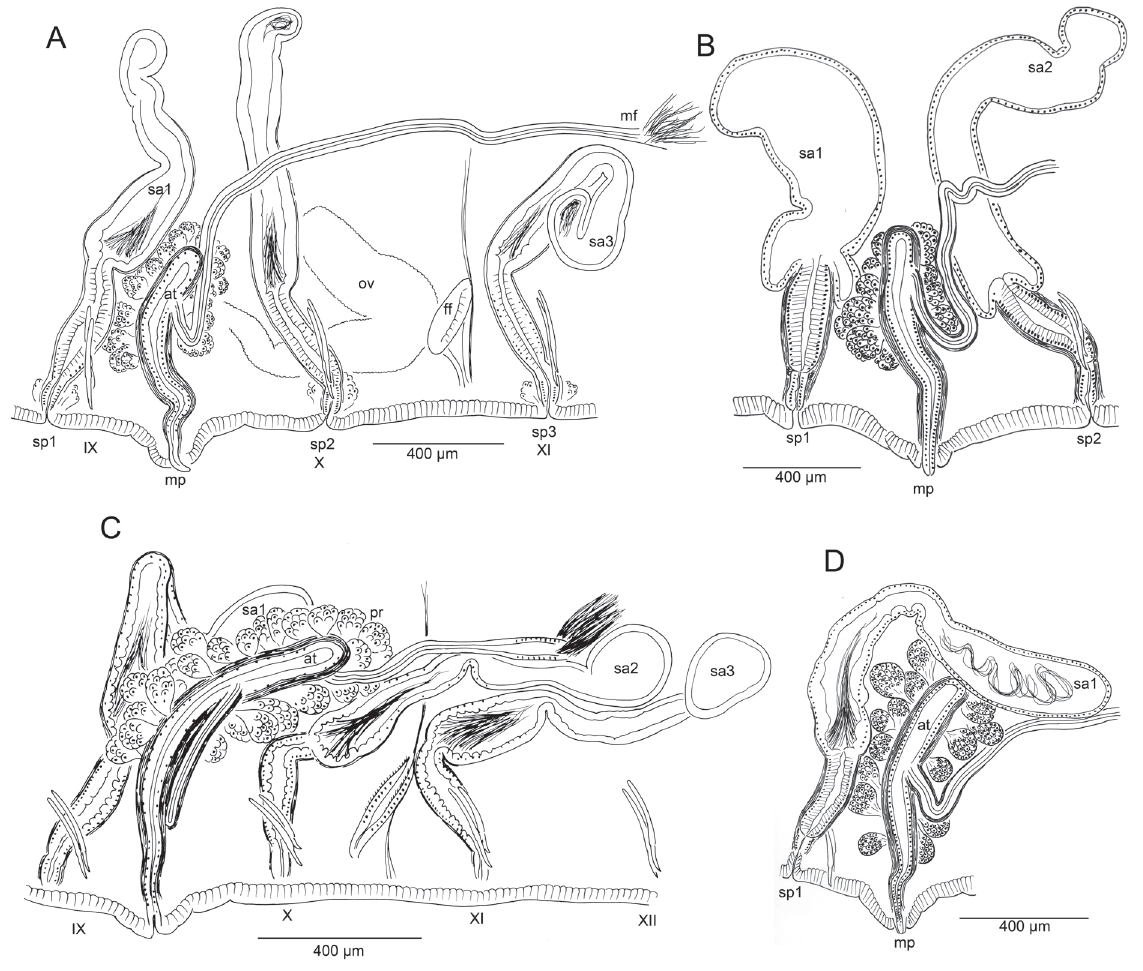
Fig. 3. Kincaidiana hexatheca Altman, 1936, reproductive organs. A–B . From Hoh River, WA; (A) segments IX-XI; (B) atrium and spermathecae with expanded ampullae in IX-X. C–D . From Rogue River, OR; (C) reproductive organs in IX-XI from an atypical worm with long atria; (D) atrium and spermatheca in IX, from a typical